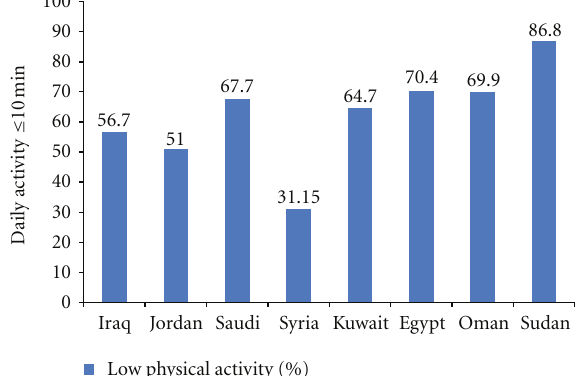
Figure 3: Prevalence of low physical activity in selected countries of the Eastern Mediterranean Region according to the STEPwise survey done by WHO